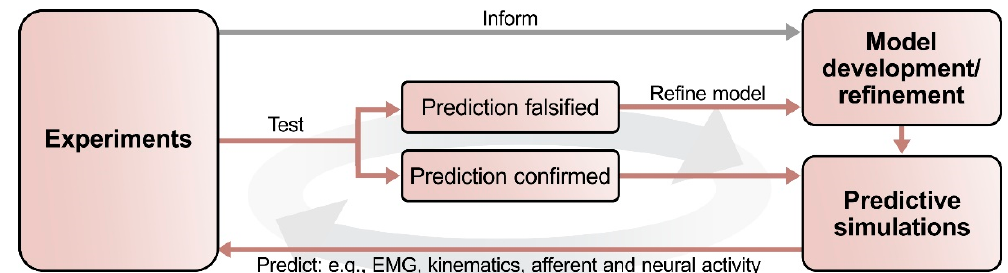
Figure 2. Outline of the suggested process of interactions between computational modeling and experimental studies. First, a set of experimental data informs the development of the initial computational model. This model should reproduce the key findings of the experimental studies. Predictions can then be generated by simulating experimentally testable conditions and manipulations that were not part of the initial set of experimental data. Next, these modeling predictions can be tested experimentally: experimental falsification of a modeling prediction will provide valuable information to refine the model; their confirmation will improve the validity of the model. When applied iteratively, this process provides an explicit and consistent theoretical framework for experimentation, thereby reducing the number of necessary experiments while simultaneously increasing the information gained per experiment.